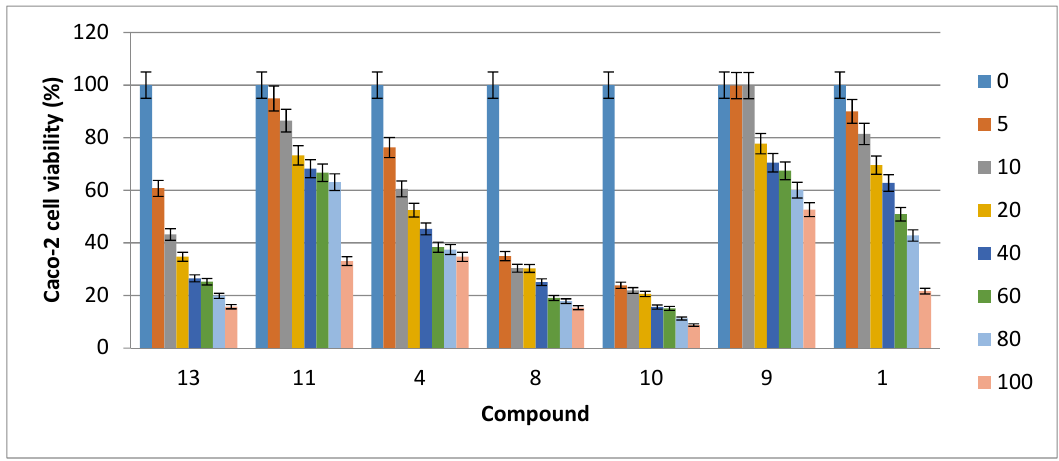
Figure 3. Anti-proliferative activities of compounds against human colorectal cancer Caco-2 cells. The MTT assay was performed three independent times ( n = 3) using di ff erent concentrations of the mentioned compounds.